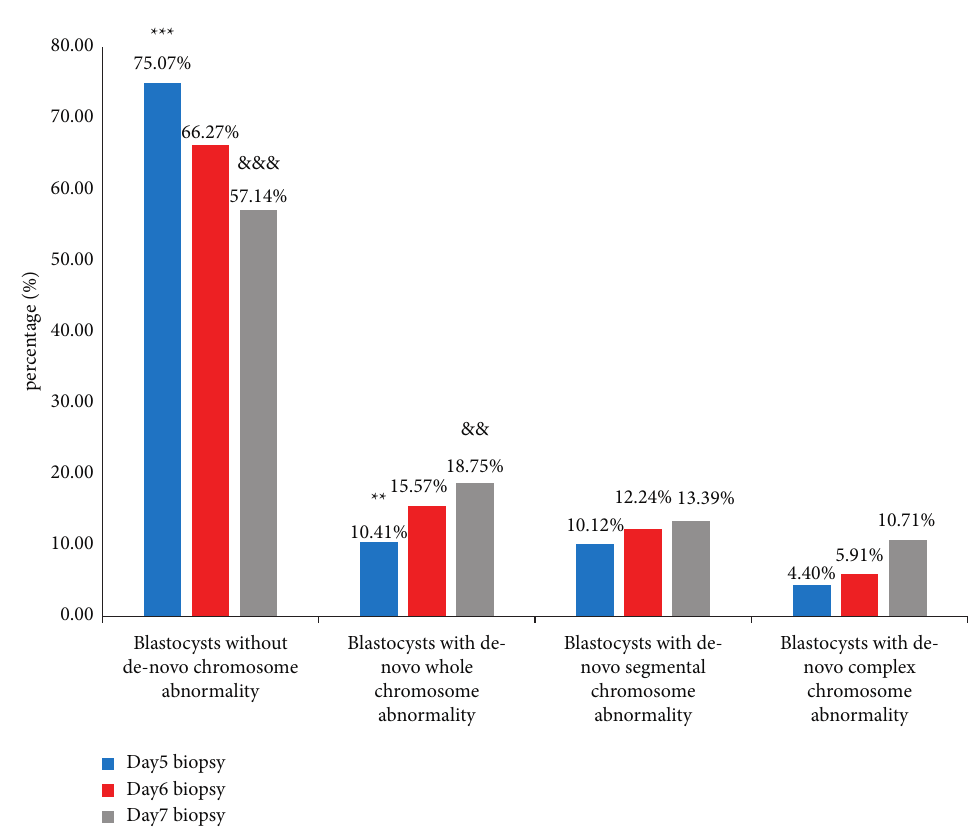
Figure 3: The proportion of blastocysts with different genetic test results related to the biopsied day. Data were presented as a percentage. Blastocysts without de novo chromosome abnormality contained euploid, mosaic and chromosome abnormalities inherited from either parent. The proportions between the three groups were tested by the chi-square test. ∗∗∗ P < 0.001 vs biopsied on D6, &&& P < 0.001 vs biopsied on D5, ∗∗ P < 0.01 vs biopsied on D6, and && P < 0.01 vs biopsied on